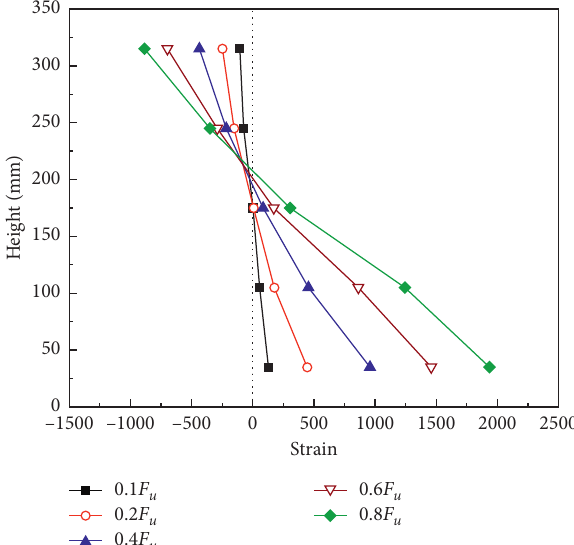
Figure 12: Central longitudinal strain